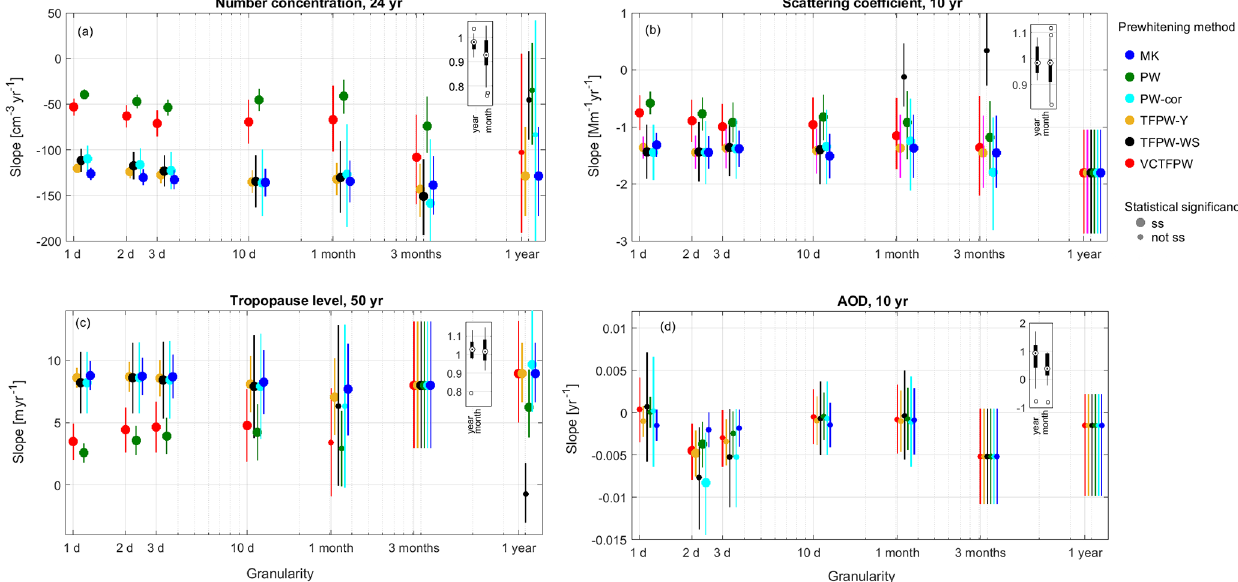
Figure 2. Slope and confidence limits computed without temporal segmentation as a function of the time granularity for MK and the five prewhitening methods (indicated by colors) for (a) the aerosol number concentration for the 24-year period, (b) the aerosol scattering coefficient for the 10-year period, (c) the tropopause level altitude for the 50-year period, and (d) the AOD for the 10-year period. Larger symbols indicate ss trends. Inserted boxplots indicate the median, the quartiles and the whiskers of the ratio between the slopes computed with no temporal segmentation (year) and with the temporal segmentation of 12 months (month) over the slopes computed with the temporal segmentation of four meteorological